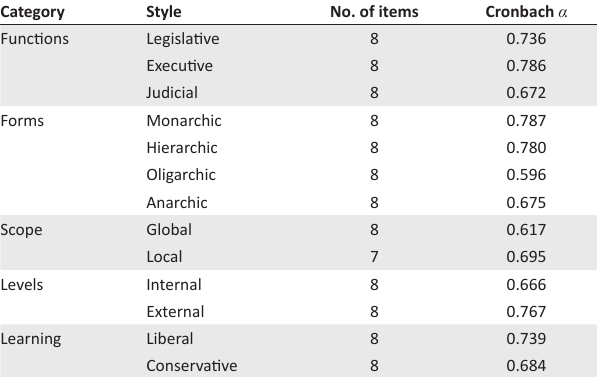
TABLE 4: Internal reliability of the thinking styles dimensions.